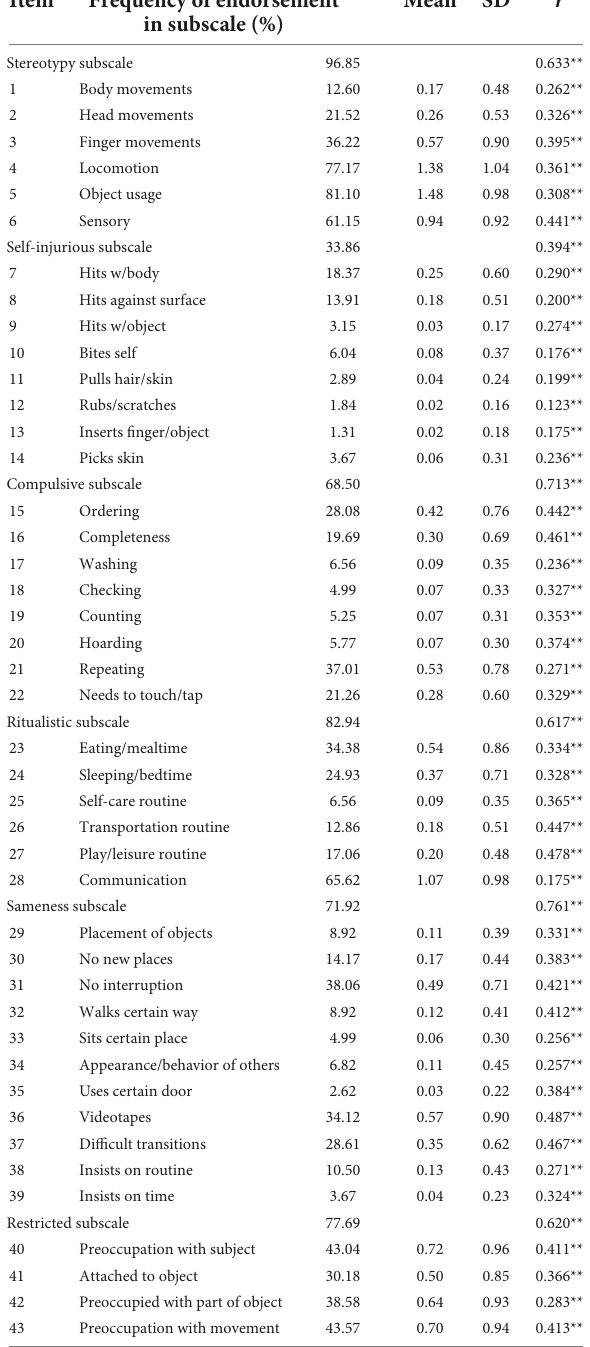
TABLE 2 Frequency of endorsement (affirmative answer) for items of the RBS-R and the spearman’s correlation coefficients between items of the total